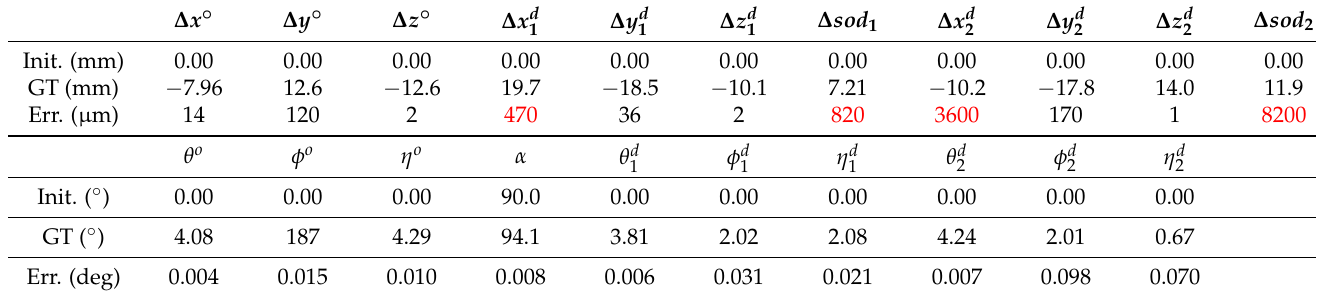
Table 1. Calibration errors of the geometric parameters for a simulated stereo X-ray CT system. Optical translations ∆ x d and ∆ sod are estimated with errors on the order of millimeters (red) due to high correlation between them. ∆ x ◦ ∆ y ◦ Init.